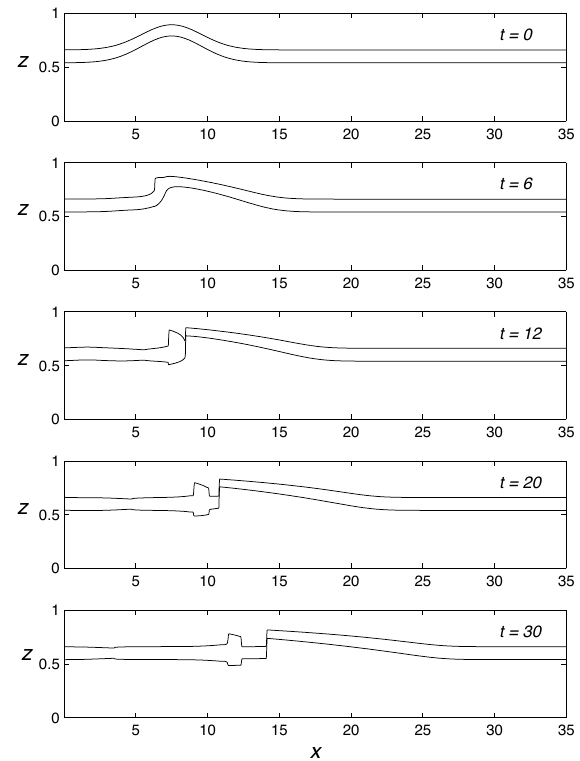
Fig. 2. The solid lines show the interface positions from a two-layer numerical solution for D 1 = 0 . 6 and D 2 = 0 . 4. The initial condition is the Gaussian interface displacement Eq. (28) with a 0 = 0 . 25, and b = 1 / 3. The initial velocity field is for simple wave with R − = sin − 1 (D 2 − D 1 ) in Eq. (20). The dashed lines shown for t ≥ 6 are the theoretical simple wave solutions that have become multi-valued after the onset of breaking at t ≈ 4 . 76. The numerical solution and the simple wave solution are nearly indistinguishable on the leading face of the wave. Note that only the upper half of the domain is shown.